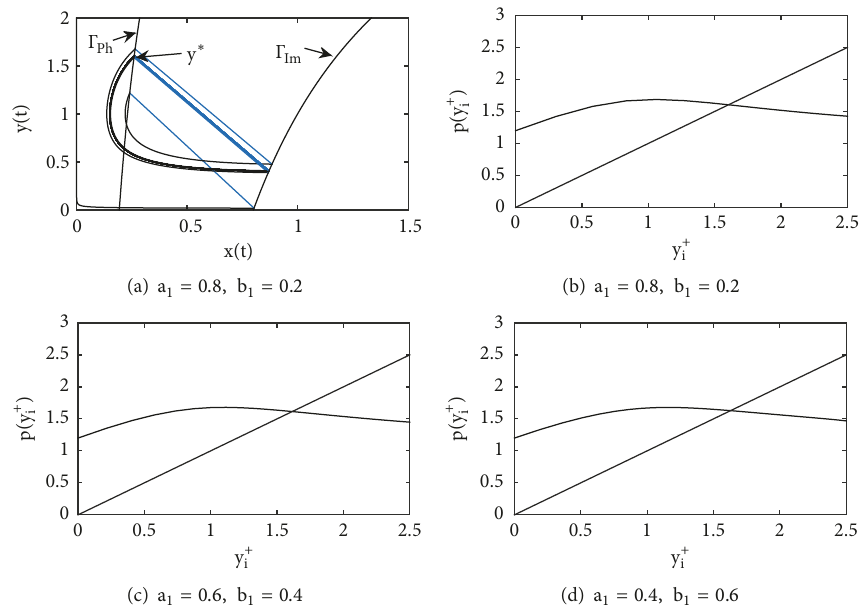
Figure 3: Complex shapes of the Poincar´e map 𝑝(𝑦 + 𝑖 ) and fixed point 𝑦 ∗ : (a) order-1 periodic solution, (b) 𝑎 1 = 0.8, 𝑏 1 = 0.2 , 𝑦 ∗ = 1.6040 , (c) = 0.6,𝑏 = 0.4 , 𝑦 ∗ = 1.6140 , and (d) 𝑎 𝑎 1 1 𝑝 = 0.7 , 𝜏 = 1.2 , and 𝐴 = 0.8